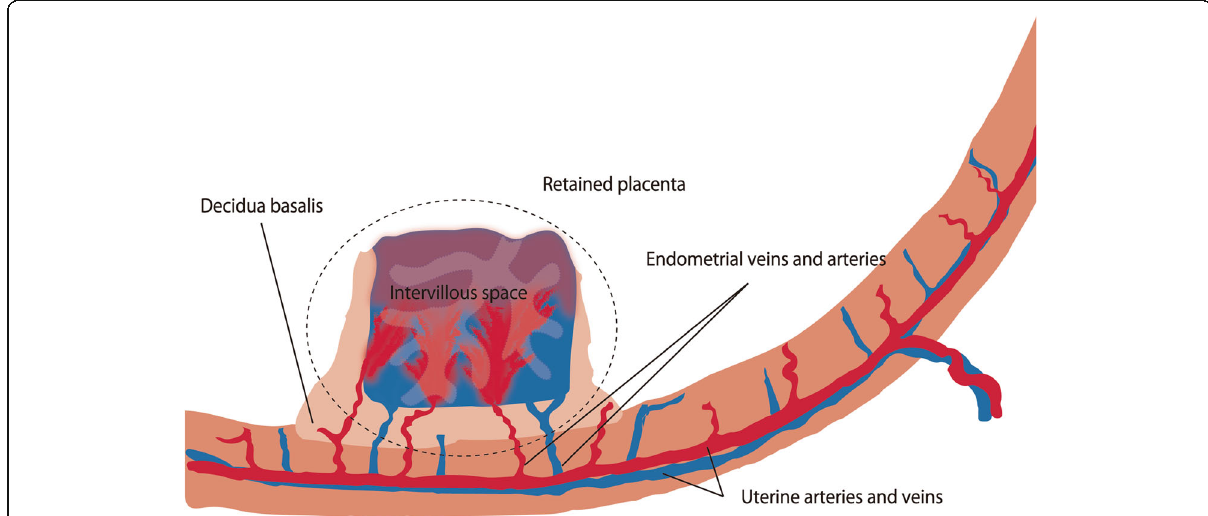
Fig. 4 Schematic drawing of the retained placenta (cross-sectional image). The retained placenta may consist of intervillous space and decidua basalis. Endometrial arteries and veins, which are branches of uterine arteries and veins, are connected to each other through the intervillous space. Angiographic findings including dilated vascular channel and contrast blush may correspond to remnant intervillous space. Endometrial arteries and veins connecting to the intervillous space may represent low-flow AVM-like